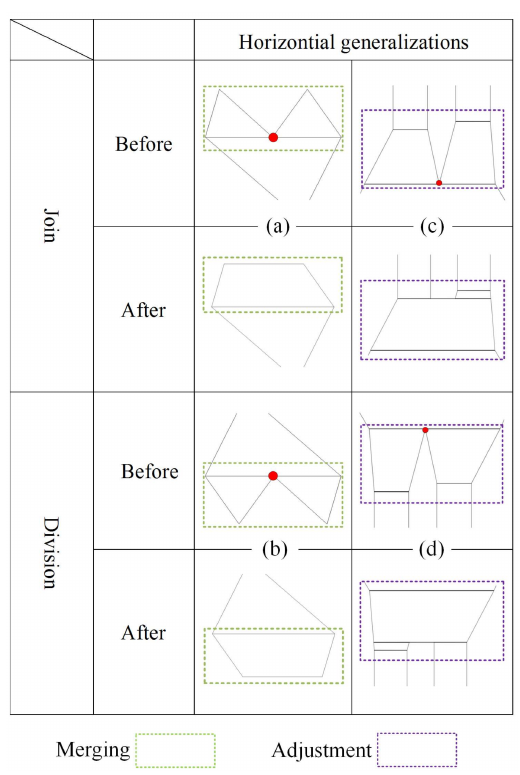
Figure 5. Horizontal trapezoidal generalizations, comprising two trapezoidal operators: merging and adjustment. ( a ) and ( b ) are two cases of merging, the two connected triangles will be merged into a trapezoid, ( c ) and ( d ) are two cases of adjustment, the two connected trapezoids will be